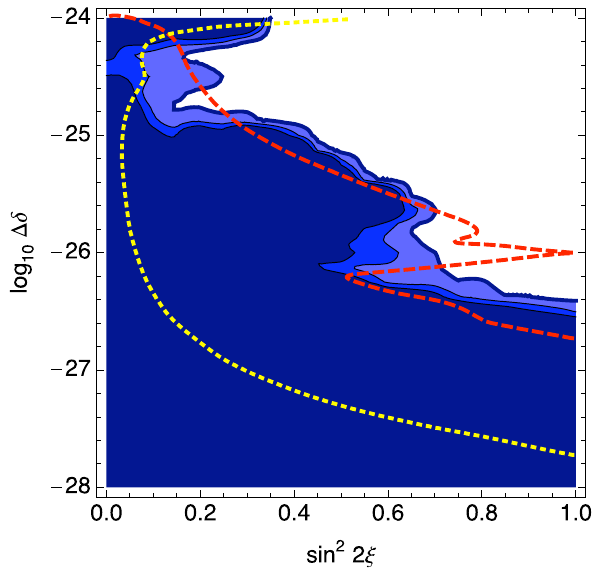
Fig. 16 Allowedregionsat90%,95%,and99%confidencelevel(from darkest to lightest) for LIV-induced oscillation effects with n = 1. Note we plot sin 2 2 ξ to enhance the region of interest. Also shown are the Super-Kamiokande + K2K 90% contour [112] (dashed line), and the projected IceCube 10-year 90% sensitivity [111] (dotted line). Reprinted with permission from [113]) (Copyright 2013 APS)